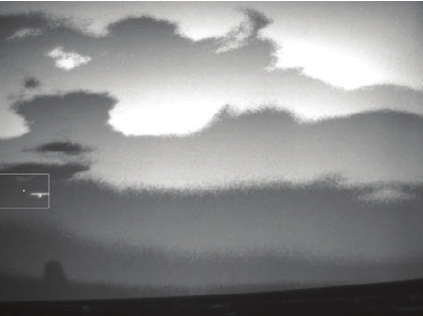
Figure 8: Synthetic image relevant to the simulated scenario, also comprising the intruder aircraft and the search window for EO obstacle detection.